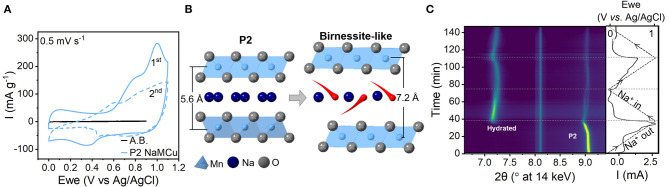
Mechanism of water intercalation into P2-type NaMCu upon electrochemical cycling in 1 M Na2SO4. (A) Cyclic voltammetry at 0.5 mV/s. A.B. indicates “acetylene black,” the electrochemical response of the conductive carbon in the electrode. (B) Cartoon showing the insertion of water molecules (red) from the electrolyte into the material interlayer to compensate for the electrochemical de-intercalation of Na+ (dark blue). (C)
Operando synchrotron XRD during the first two CV cycles at 0.5 mV/s. The right-most panel shows the applied potential (dashed line) and the current response (solid line). During the first anodic cycle, the interlayer peak of the hydrated birnessite-like phase (~7°2θ) emerges around 0.9 V. Both the P2 and the hydrated peak show reversible, continuous changes in the interlayer spacing as a function of potential attributed to Na+ de/intercalation. The peak at 8.1°2θ is due to the electrochemical cell.